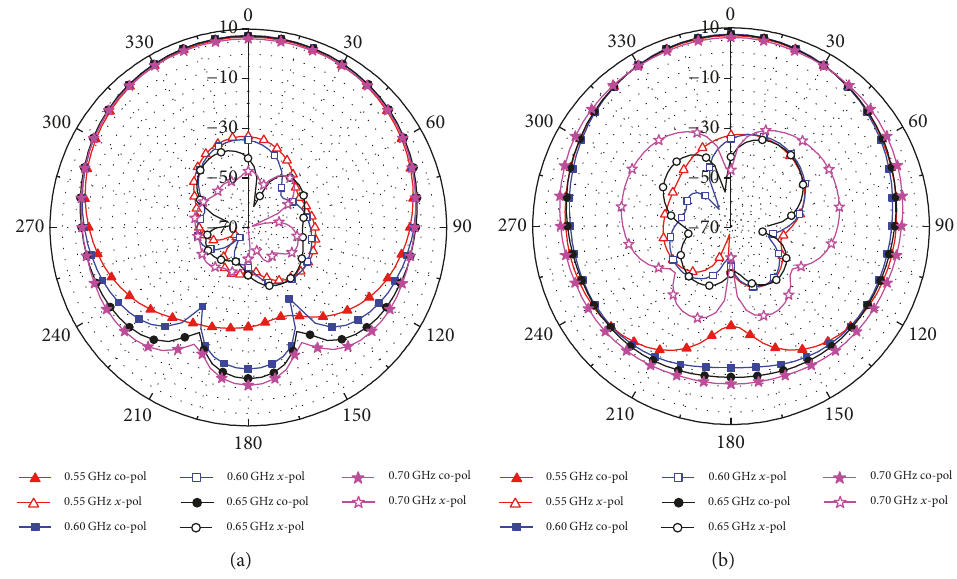
Figure 4: The radiation patterns of the bow tie antenna on 6 × 6 HIS array: (a) 𝐸 -plane ( 𝑧 - 𝑥 ) and (b) 𝐻 -plane ( 𝑧 - 𝑦 ).